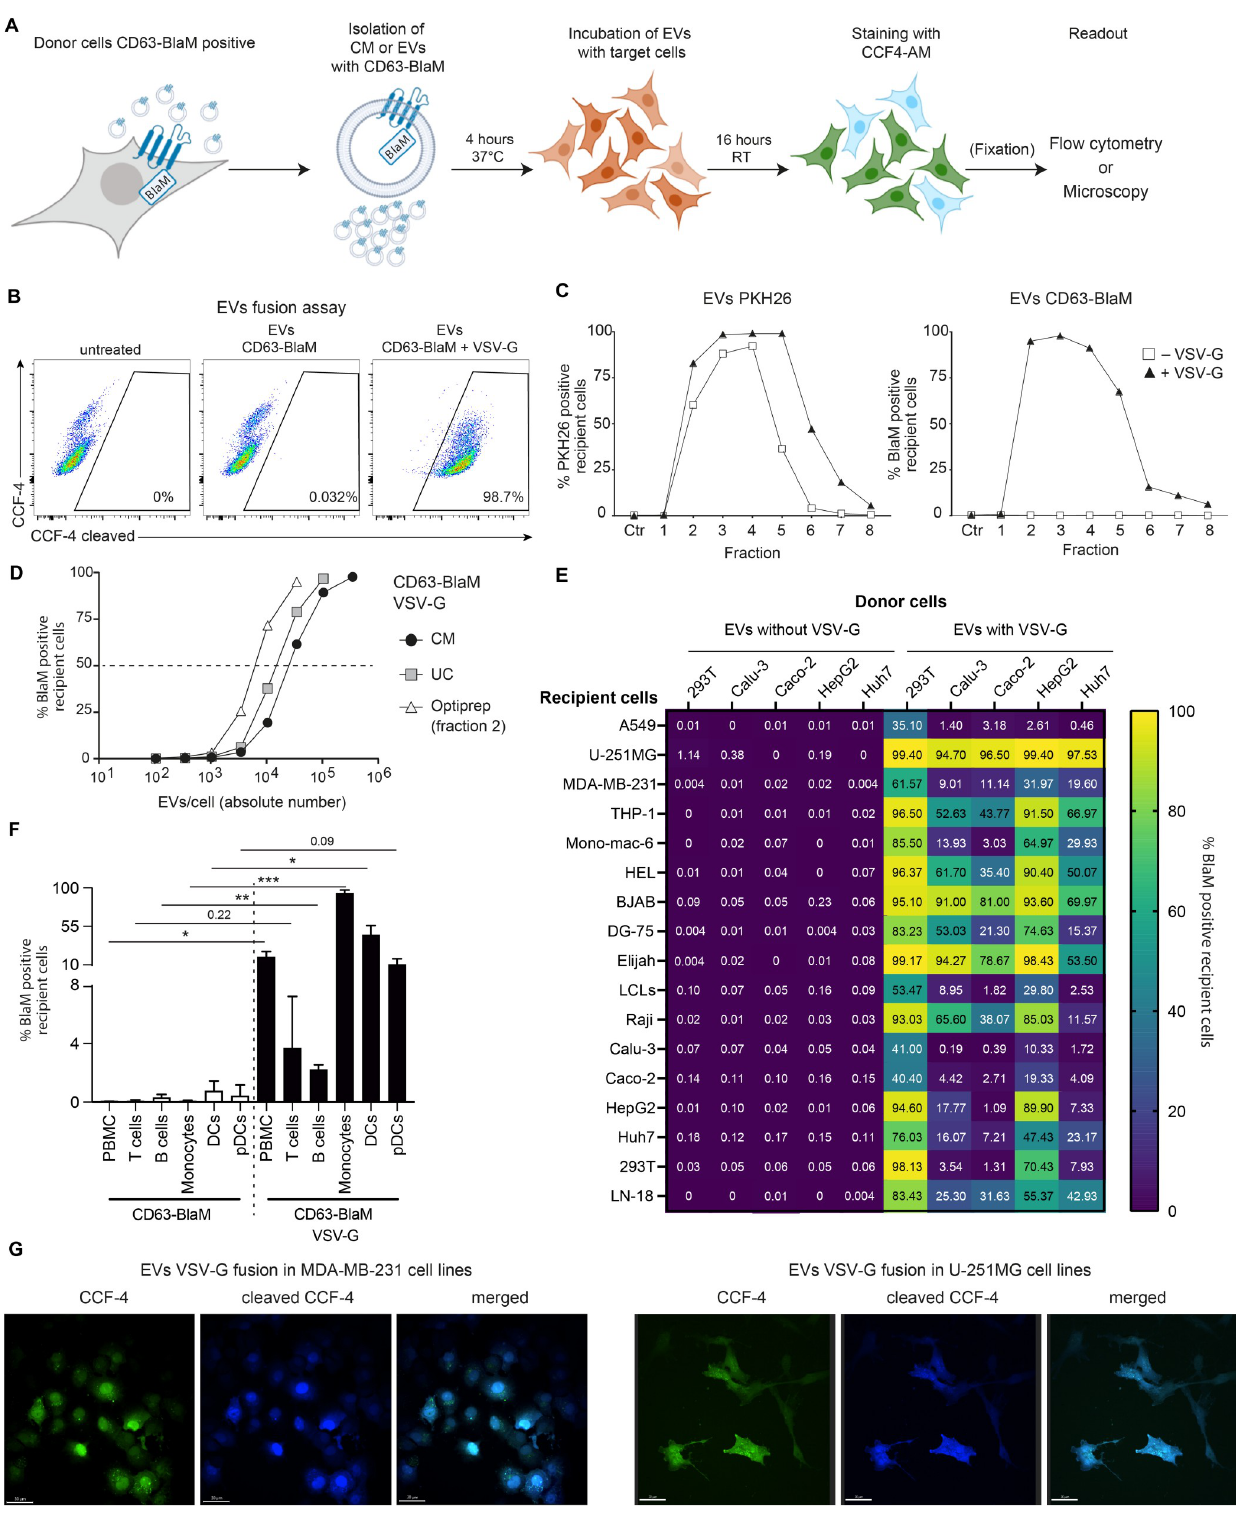
PLOS Genetics | https://doi.org/10.1371/journal.pgen.1009951 December 6,